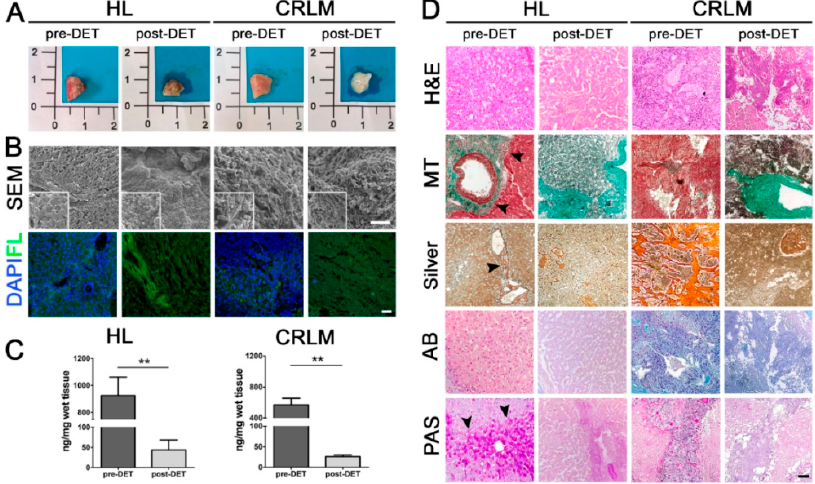
Figure 1. Decellularization and characterization of organotypic patient-derived decellularized scaffolds of colorectal cancer liver metastases. ( A ) Gross appearance of healthy liver (HL) and colorectal cancer liver metastasis (CRLM) tissue samples, before (pre-detergent-enzymatic treatment (DET)) and after (post-DET) two decellularization cycles. ( B ) Scanning electron microscope and immunofluorescence images of fresh and decellularized biopsies of HL and CRLM. DAPI: 4 (cid:48) ,6-diamidin-2-fenilindolo (blue); FL: autofluorescence of tissue samples to show tissue preservation (green). Scale bar: 100 µ m. ( C ) DNA quantification of tissue samples before and after decellularization; n = 3. ** p -value < 0.01 by Student’s t -test. ( D ) Histological staining of HL and CRLM samples pre-DET and post-DET.; H&E: Haematoxylin and Eosin; MT: Masson’s Trichrome, with fibrillar collagens indicated by black arrow heads; Silver: Silver stains, with reticular collagens indicated by black arrow heads; AB: Alcian blue; PAS: Periodic Acid-Schi ff , with glycogen indicated by black arrow heads. Scale bar: 100 µ